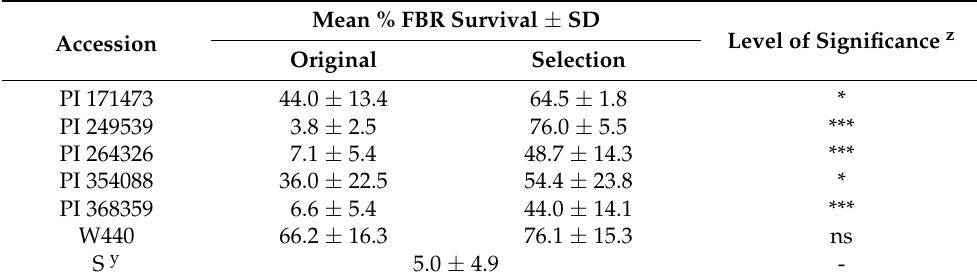
Table 1. Mean percentage (%) survival ± standard deviations (SD) and level of significant differences between original unselected plant introductions (PIs) or inbreds of onion versus progenies from one cycle of selection for resistance to Fusarium basal rot (FBR).